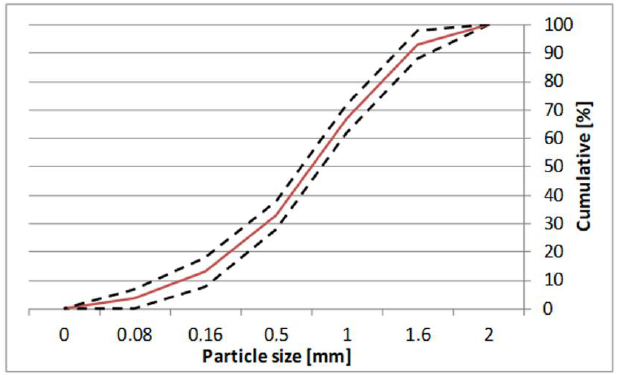
Figure 1. The particle size distribution of standard sand, according to EN-197-1 [55].